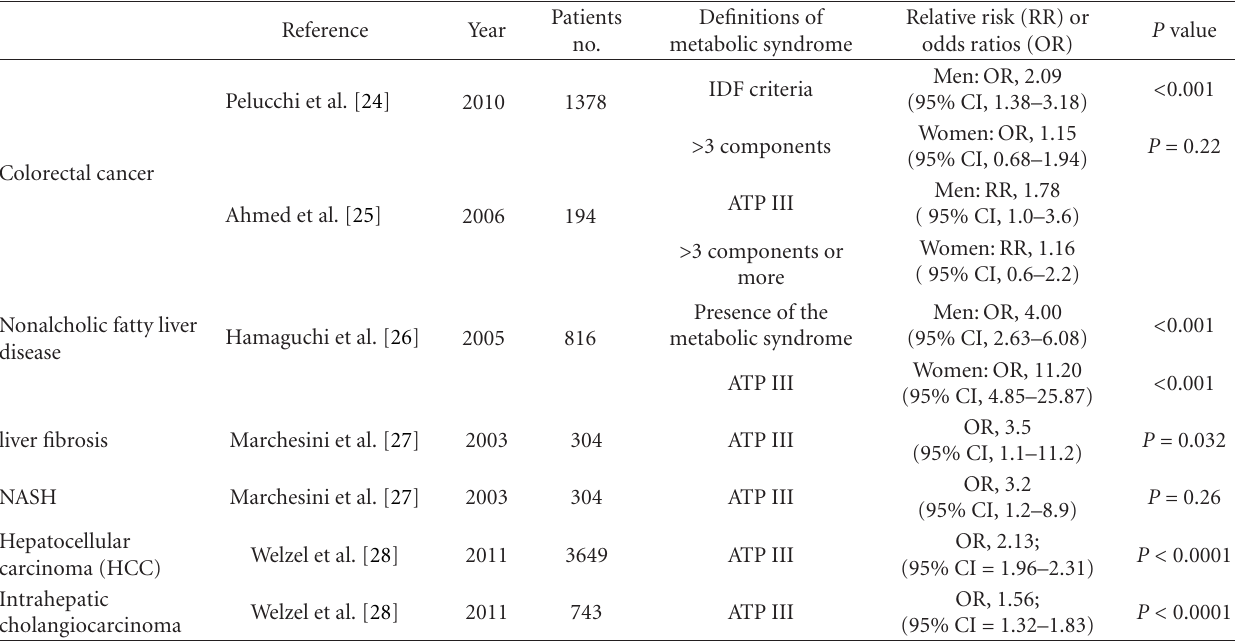
Table 2: Metabolic syndrome and gastrointestinal